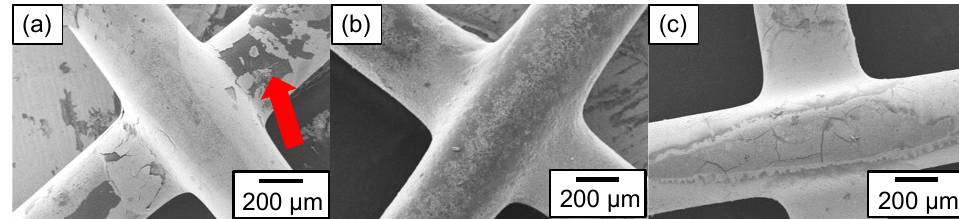
Figure 6. SEM images of the ( a ) TiO 2 net that TiO 2 layer peeling are observed near the red arrow, ( b ) HDTMS-TiO 2 net, and ( c ) APTES-TiO 2 net after strong artificial sunlight irradiation.